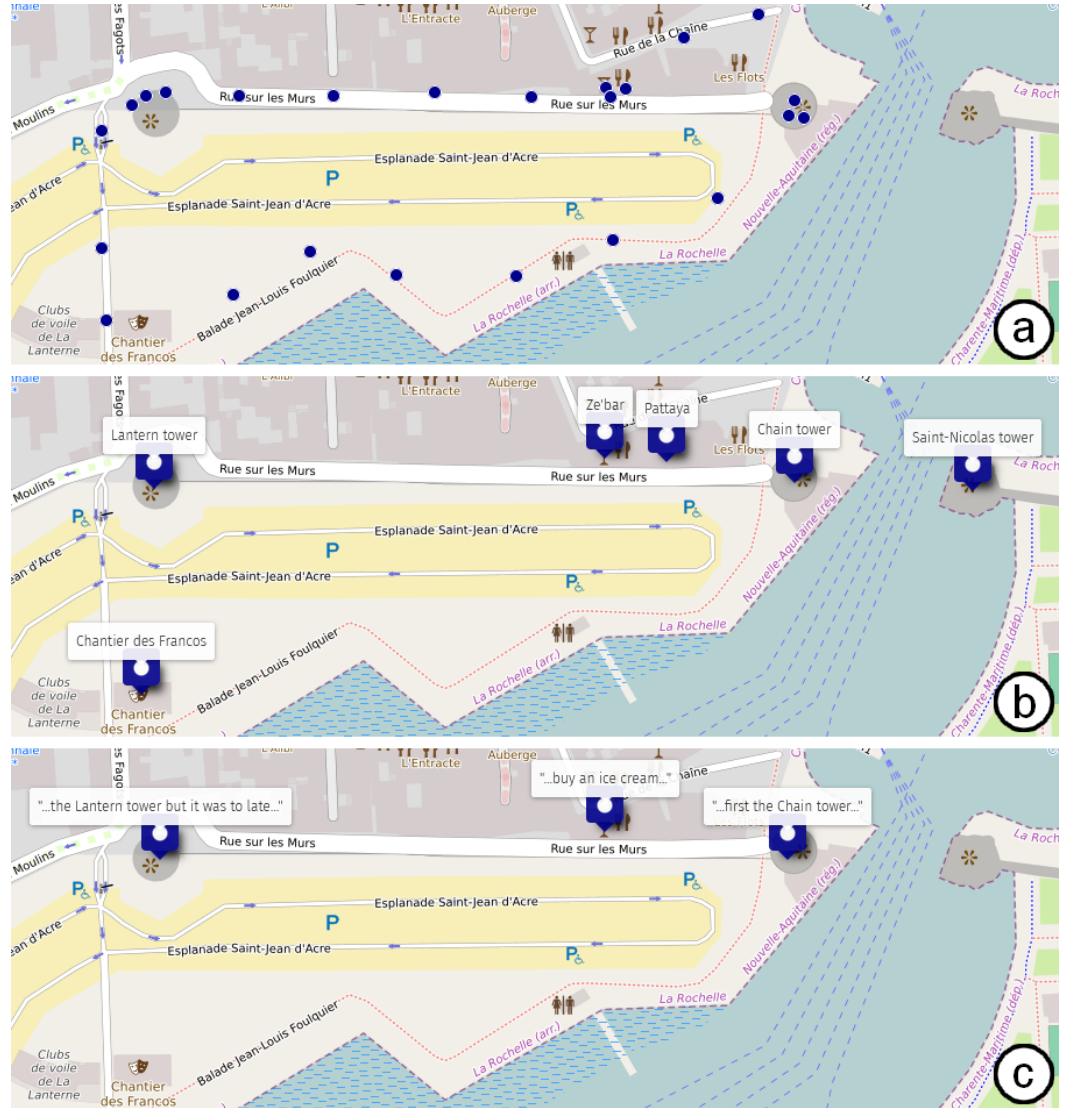
Figure 1. ( a ) Extract of a mobility track from the Geoluciole application, each point corresponds to a spatio-temporal position of a tourist visiting La Rochelle; ( b ) points of interest of the city from Open Data; ( c ) extracts of the interview corresponding to the